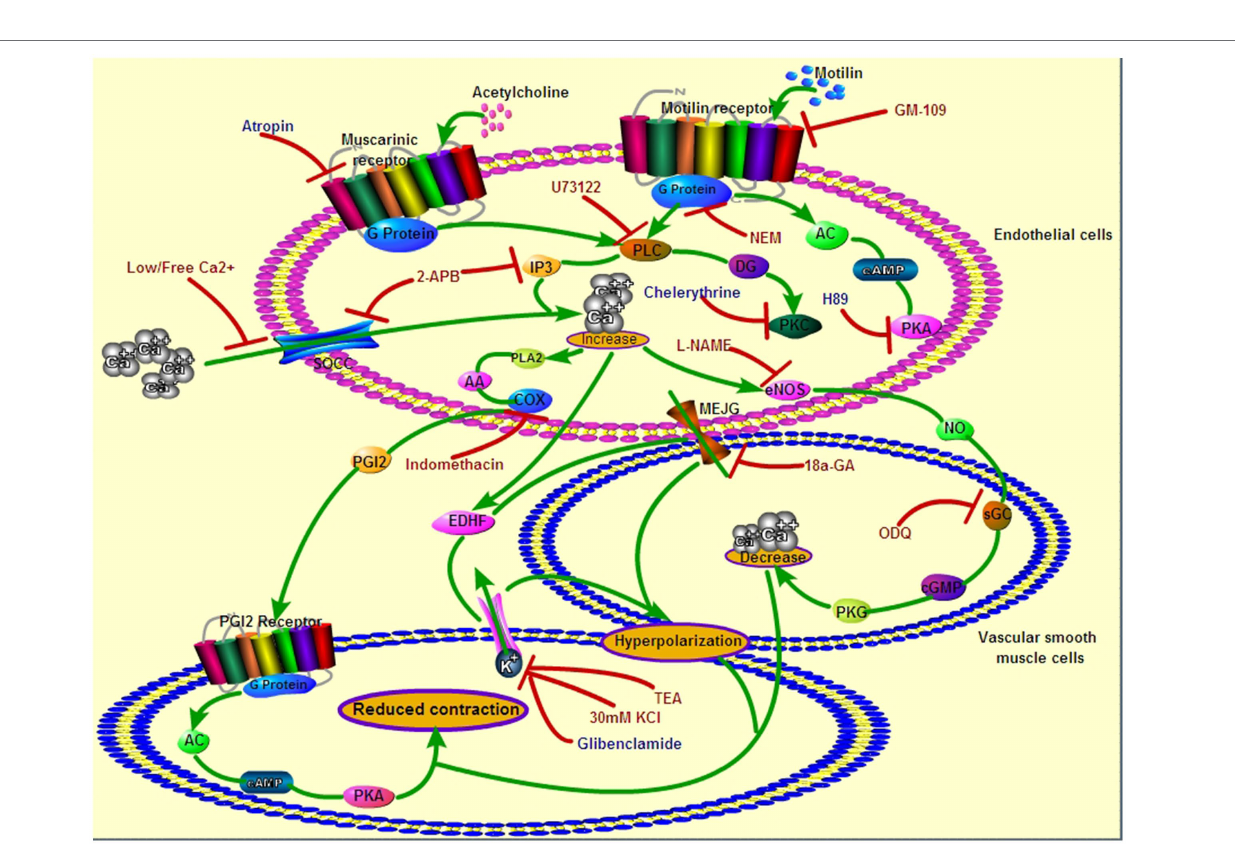
FIGURE 11 | Roles of endothelial MLNR and its signal transduction pathway on LGA SMC relaxation. Green arrows indicate the signaling pathways in EC and SMC during motilin- or acetylcholine-induced relaxation of the dog LGA. Red arrows with flat heads indicate the blocking effect of inhibitors on the signaling pathways. The drugs in red indicate an inhibitory effect on MLNR signaling pathways, and those in blue indicate no inhibitory effect. EC, endothelial cell; LGA, left gastric artery; MLNR, motolin receptor; and SMC, smooth muscle